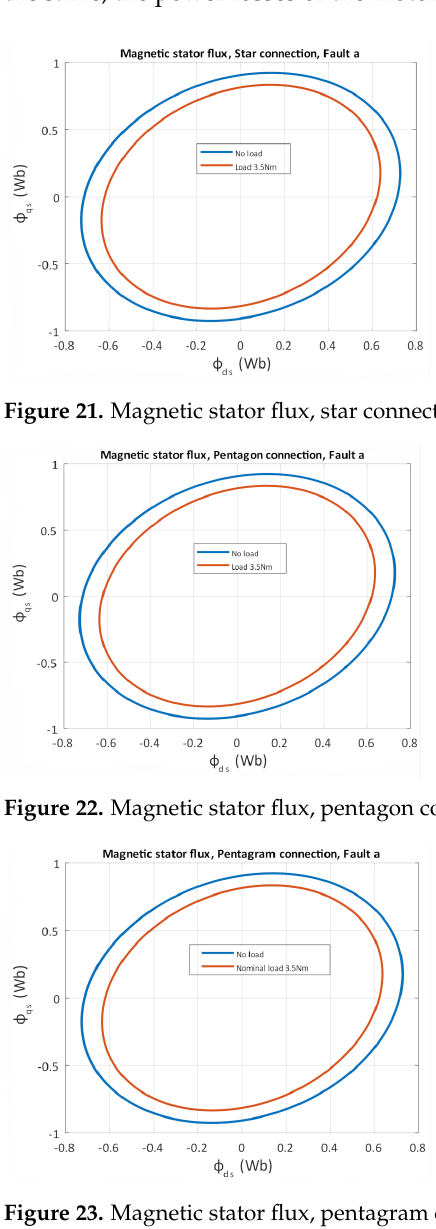
Figure 23. Magnetic stator flux, pentagram connection, fault phase a.